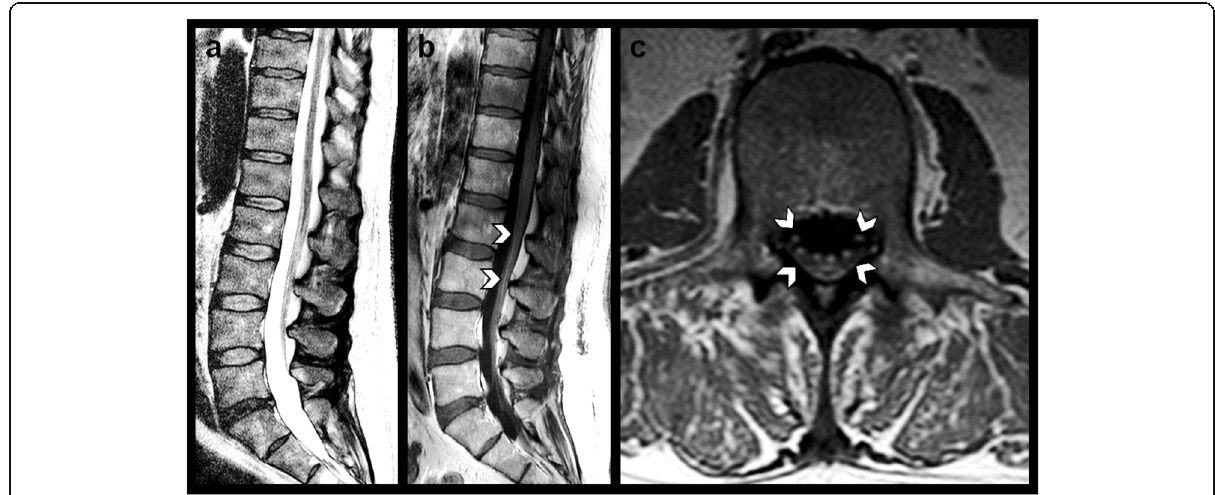
Fig. 1 Contrast-enhanced whole-spine MRI performed 2 h after symptom onset. a Sagittal T2-weighted image showing no signal abnormalities of the spinal cord. b Sagittal and c axial T1-weighted images after administration of gadolinium-based contrast agent revealing smooth contrast enhancement of the conus medullaris and the anterior and posterior roots of the cauda equina (arrows) extending beyond the spinal canal into the lumbosacral nerve roots. All MR imaging was performed on a clinical 1.5 T MR scanner (Achieva, Philips Healthcare, Best, the Netherlands) and included a T1-weighted spin-echo sequence (405/7 ms [repetition time (TR)/echo time (TE)] before and after administration of a Gd-DO3A-butrol- based contrast agent (Gadovist, Bayer, Leverkusen, Germany) in axial and sagittal orientation, a T2-weighted turbo spin-echo sequence [2800/90 ms (TR/TE)] as well as a sagittal T2-weighted modified Dixon (mDixon) spin-echo sequence [2800/90 ms (TR/TE)]